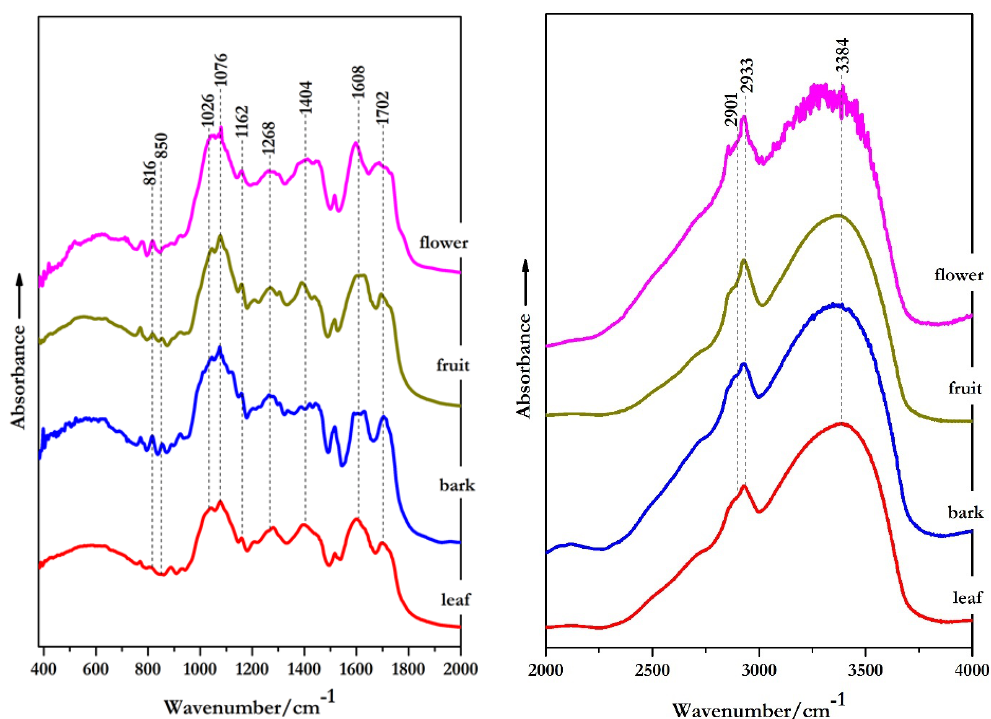
Figure 1. The FT-IR absorbance spectra of S. vulgaris flowers, bark, leaves and fruit extracts. The profiles are presented in the wavenumber range 400–2000 cm − 1 ( left ) and 2000–4000 cm − 1 ( right ). Table 2. Peak positions (cm − 1 ) and tentative assignments of FT-IR absorbance bands for S. vulgaris extracts from the leaves, bark, flowers and fruit recorded in the spectral region from 400 to 2000 cm − 1 . S. vulgaris